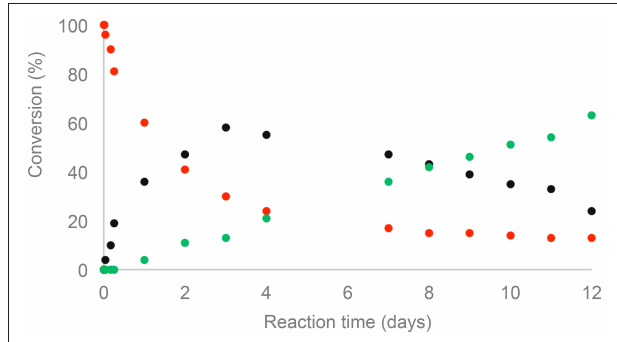
FIGURE 2 | Kinetic monitoring by 1 H NMR of transesterification of 5-norbornne-2endo,3endo-dimethanol ( 3 ) with ethyl dihydrosinapate ( 2 ): ( 3 ),